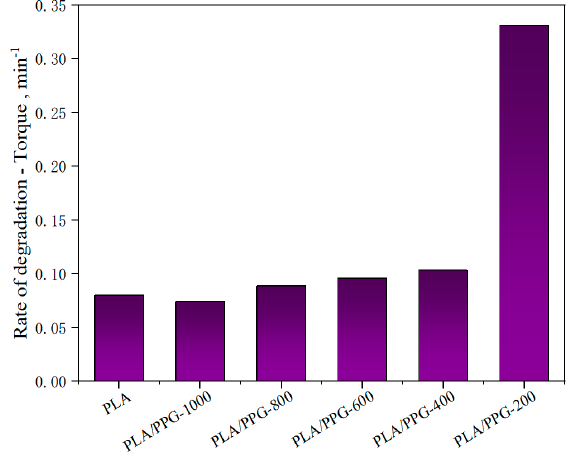
interval from 15 to 20 minutes for the neat PLA and PLA/PPG composites.